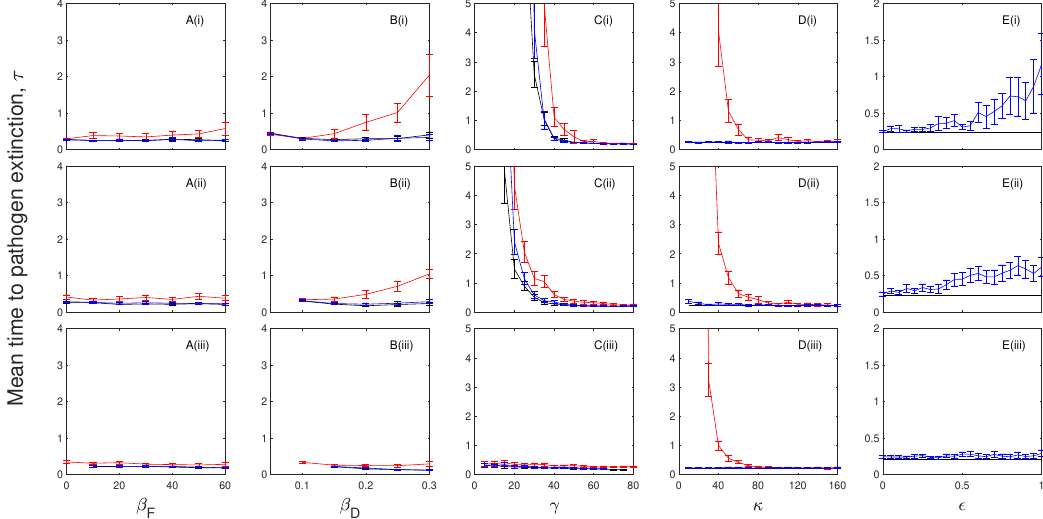
Figure 7. A parameter sensitivity analysis for the SIR (black) and SICR model frameworks with a chronically infected class that exhibits disease-induced mortality ( c = 0.5, (cid:101) = 0, blue) and a chronically infected class that can transmit the infection ( c = 0, (cid:101) = 0.5, red) for ( i ) α = 10, ( ii ) α = 40 and ( iii ) α = 80. The mean time to pathogen extinction (with 95% confidence intervals) is plotted against ( A ) the frequency-dependent transmission rate, β F ; ( B ) the density-dependent transmission coefficient, β D ; ( C ) the infected recovery rate, γ ; ( D ) the chronically infected progression rate, κ ; and ( E ) the chronically infected infectiousness, (cid:101) . When not changed in the figure baseline parameter values were used (see Table 2). Red lines are not shown in ( E(i) ) and ( E(ii) ) as this scenario assumes chronic individuals are